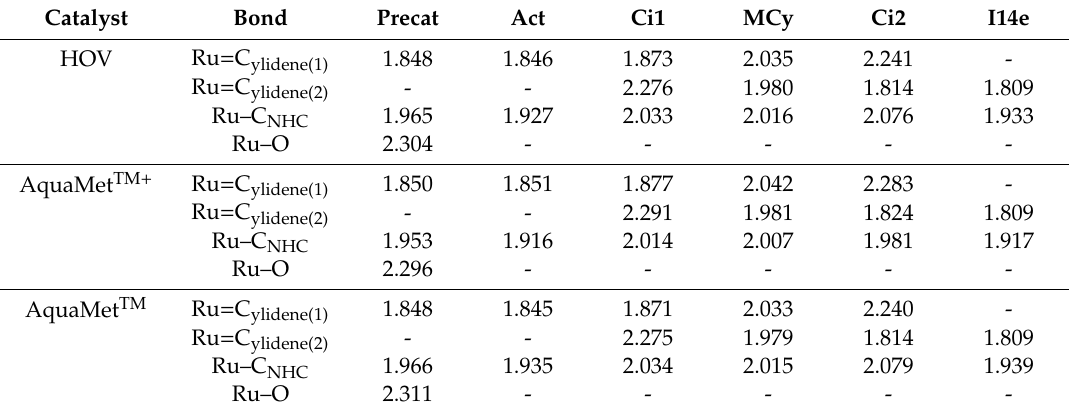
Table 2. Main distances for catalysts HOV, AquaMet TM and MOF-AquaMet TM (in Å).